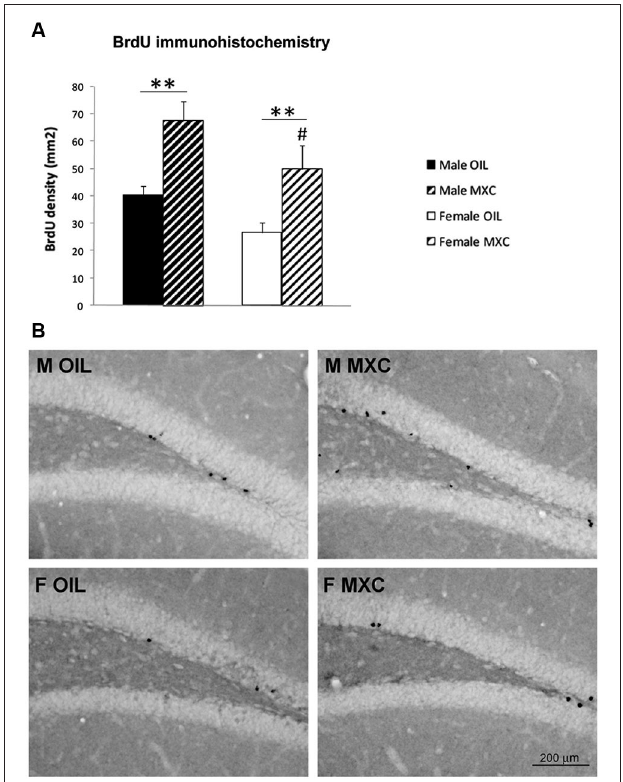
FIGURE 6 | Perinatal MXC exposure increased BrdU+ cells in the dentate gyrus of the hippocampus. (A) The density of BrdU+ cells increased in both sexes in MXC-treated mice. Density of cells survival was higher in male compared to female mice. Data are expressed as mean ± SEM. ** p < 0.01; # p < 0.05 in Males vs. Females. (B) Representative BrdU staining in the dentate gyrus (DG) of the hippocampus for each group.